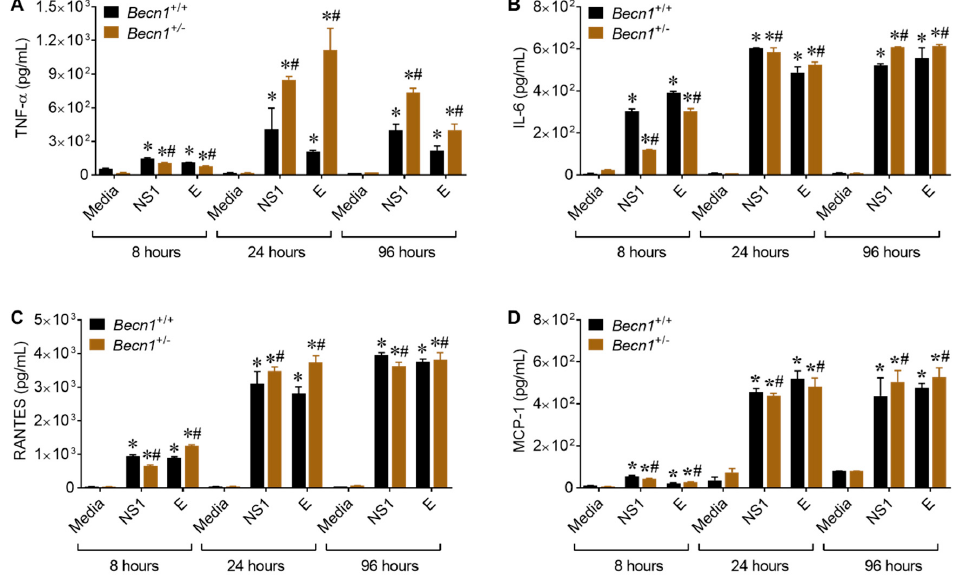
Figure 5. Potential link between ZIKV proteins and Beclin1 protein. ( A – D ) The secretions of pro-inflammatory molecules were detected in glial supernatants exposed to 50 nM of viral proteins after 8, 24- and 96-h by ELISA. Becn1 +/+ glia (black bar) and Becn1 +/ − glia (brown bar). The data were analyzed by two-way ANOVA followed by Tukey’s multiple comparison test. * p < 0.05 vs. respective media control, # p < 0.05 vs. Becn1 +/+.